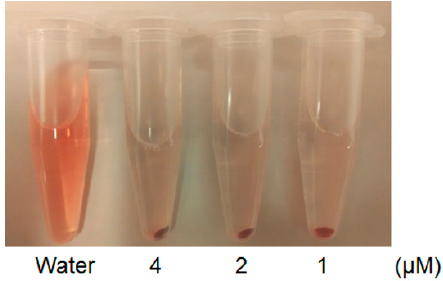
Figure 5. Hemolysis assay of Cy5-BF 3 ( 19 F) after 4 h of incubation with red blood cells (RBCs). Complete RBC hemolysis is observed in deionized water (control, left, shows lack of pelleting and red colored supernatant). Hemolysis is not observed with 4, 2, or 1 µM Cy5-BF 3 in isotonic phosphate-buffered saline (pH = 7.4, PBS).